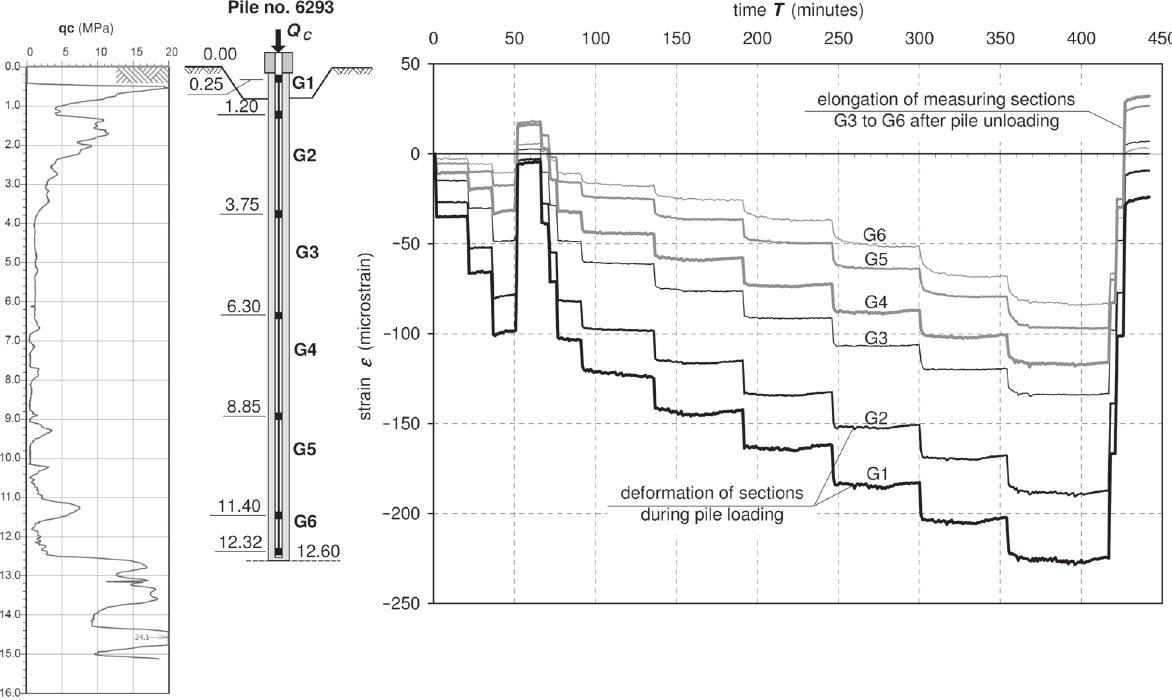
Figure 4: An example of test result with the presence of initial compressive (residual) force in the pile shaft found due to shaft elongation after unloading (pile no.